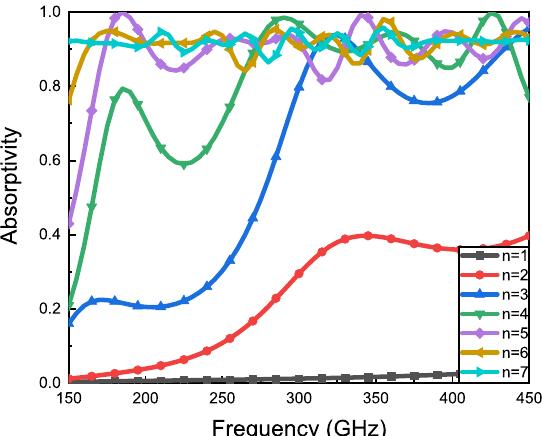
Figure 3. Absorptivity versus frequency with different n